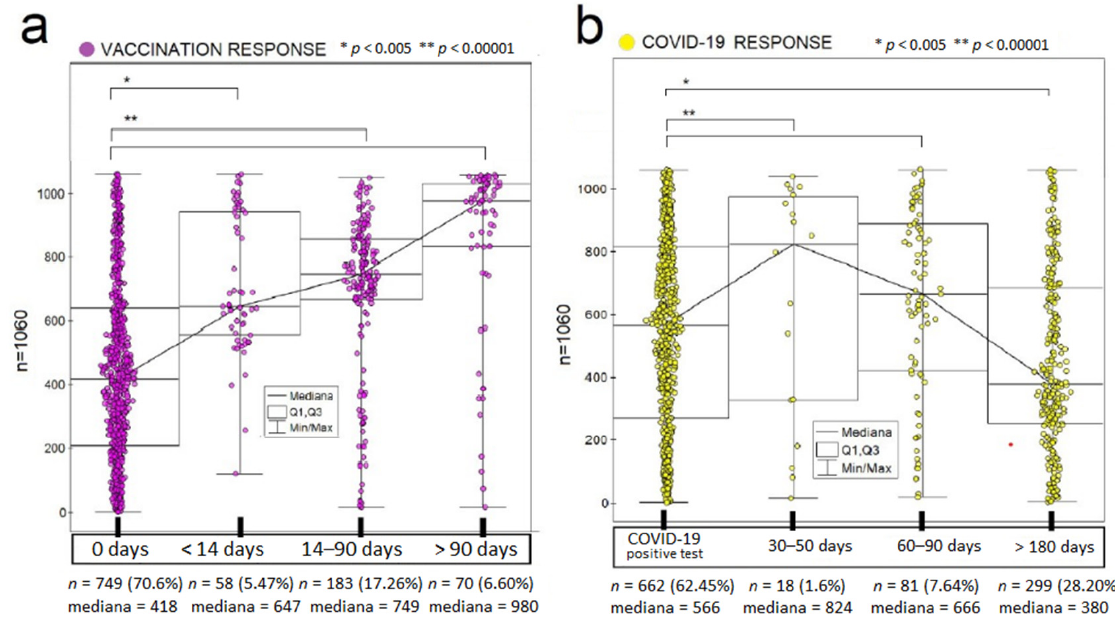
Figure 4. The determination of antibodies in the study groups at intervals ( a ) after full vaccination and ( b ) after obtaining a positive result for SARS-CoV-2 (COVID-19 positive test) ( p < 0.005 appropriately; Kruskal–Wallis).